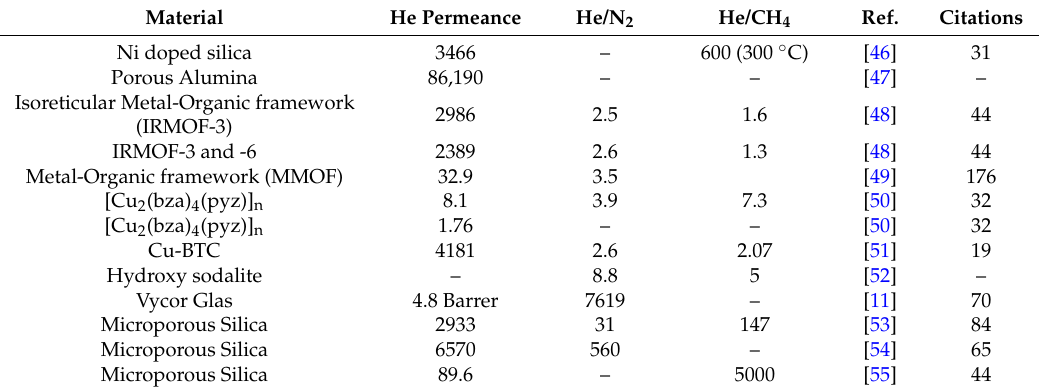
Table 3. He permeance (GPU), He/N 2 and He/CH 4 selectivities in a range of inorganic membranes.